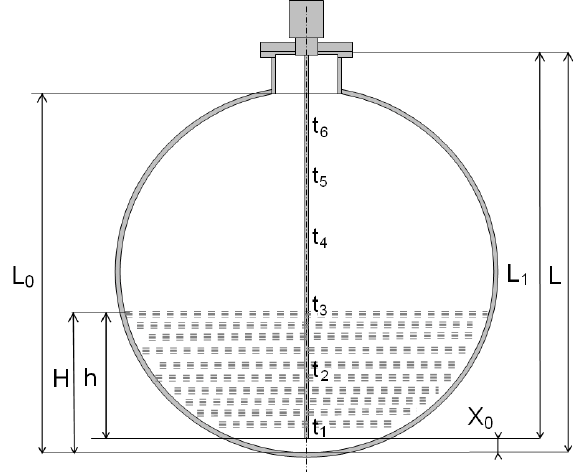
Fig. 4. Position of sensors in a